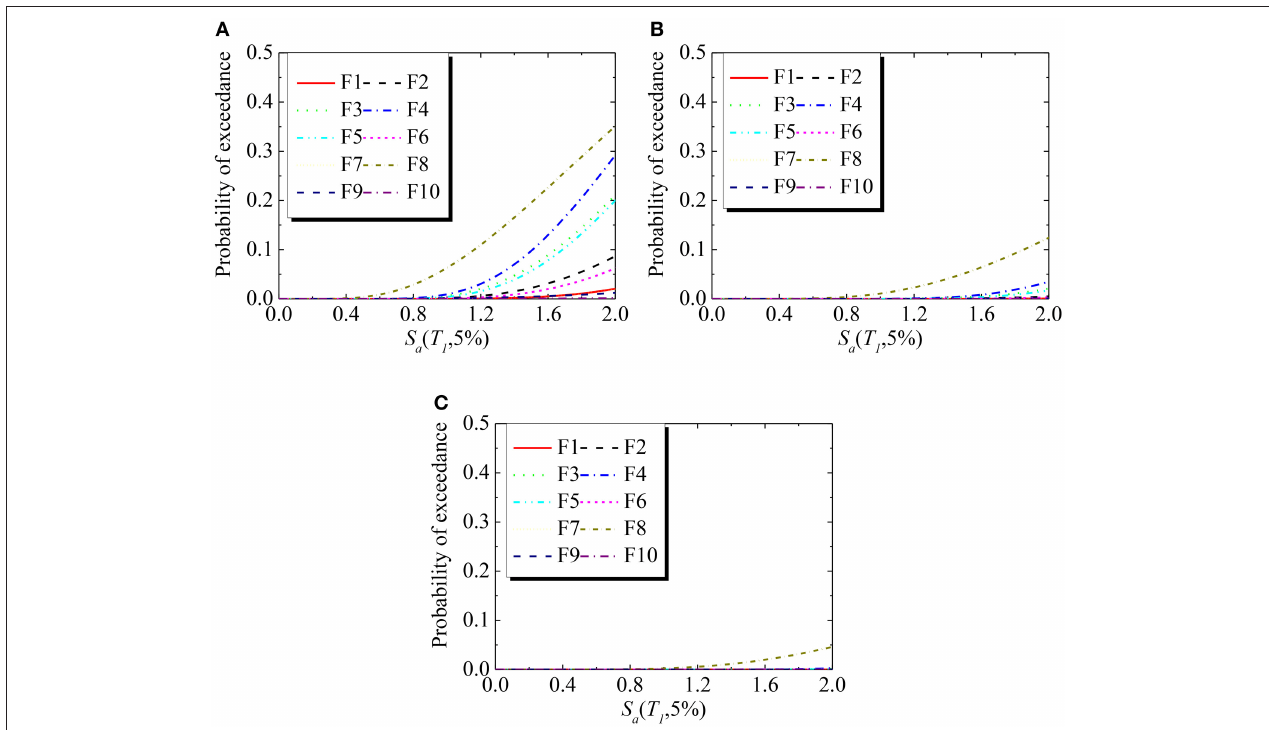
FIGURE 20 | Fragility curves of grooved fit joints (DN150) of the pure frame (A) DS 1 (B) DS 2 (C) DS 3